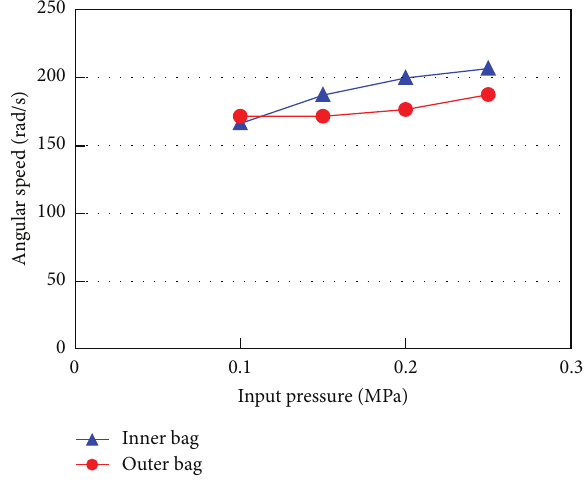
Figure 12: Motion speed comparison between inner and outer